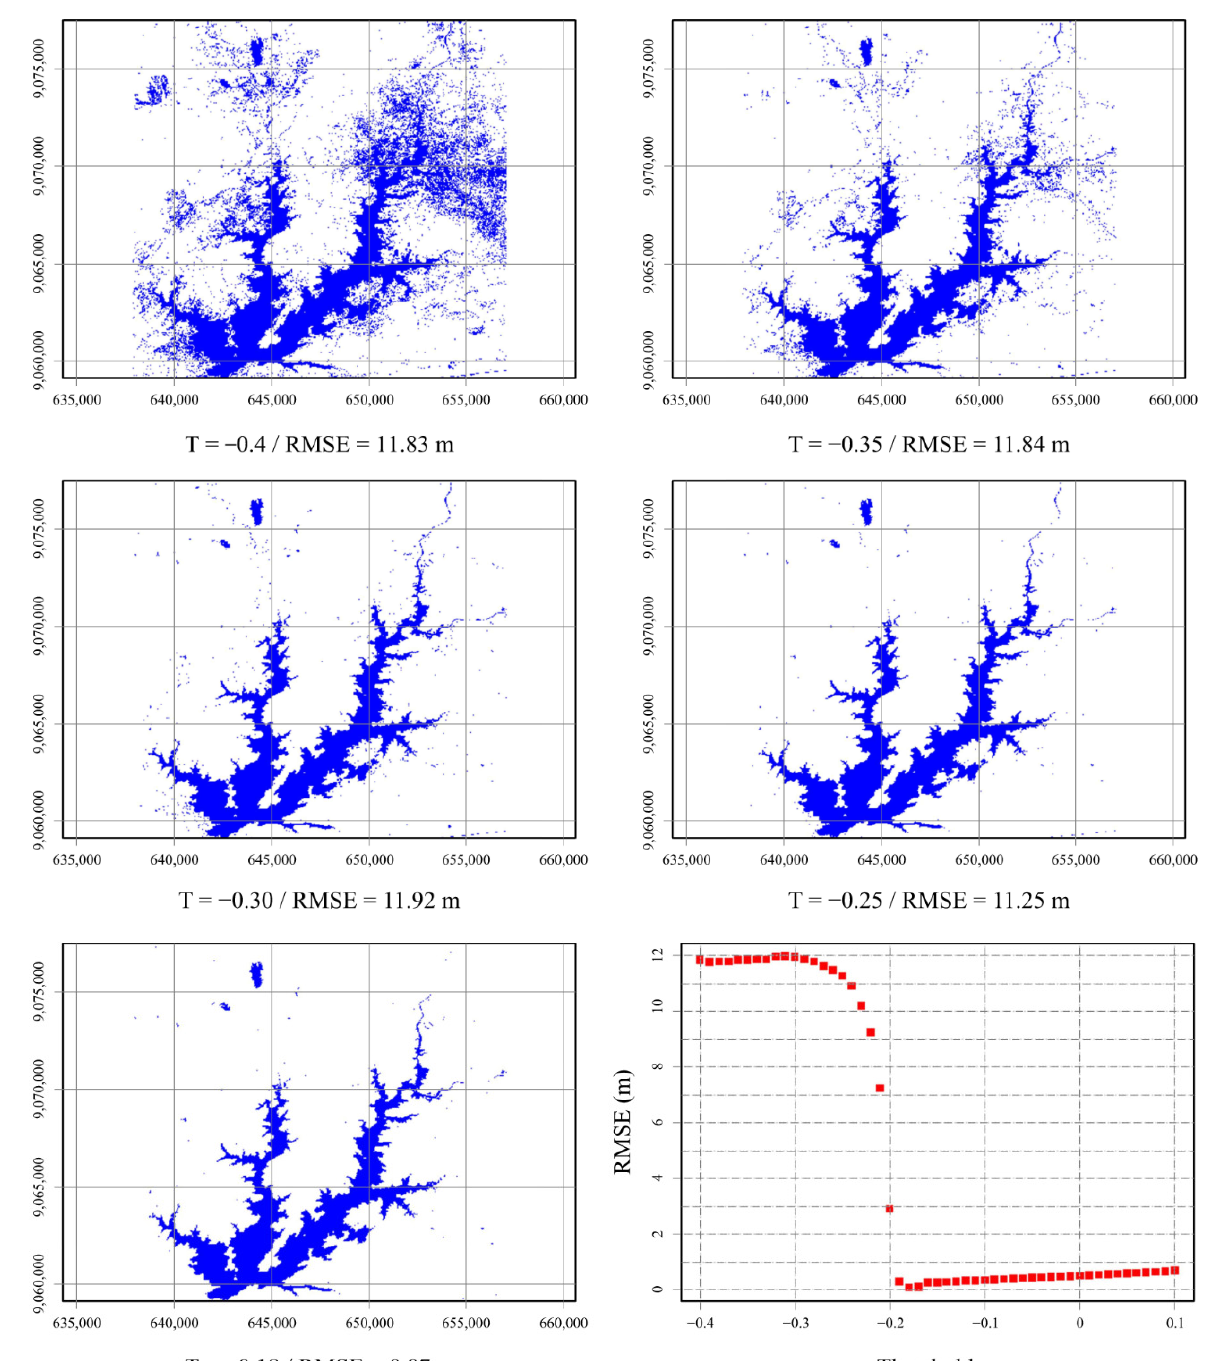
Figure 7. Threshold’s variation effect in water pixel classification noise.